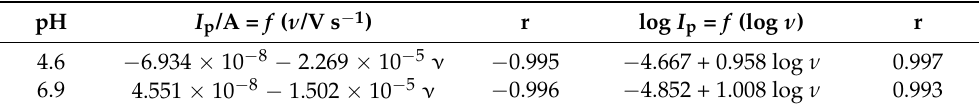
Table 1. Regression equations and correlation coefficients of the I p = f ( ν ) and log I p = f (log ν ) linear dependences, in acidic and neutral medium.